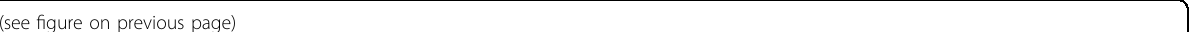
Fig. 3 PARKIN knockout increases extended-access methamphetamine self-administration (EA METH SA) and METH reward. A Timeline of EA METH SA experiment. B , C Escalation of METH taking in Parkin gene knockout (PKO) rats as compared to wild-type (WT) rats during an increasing ratio schedule of reinforcement: FR1, FR2, and FR5. The PKO rats pressed for METH at a signi fi cantly higher rate than the WT rats ( B ) with a consequent higher consumption of METH ( C ). There was no signi fi cant difference between PKO and WT rats in respect of the number of presses for saline ( B inset, n = 4/group). * p < 0.05, ** p < 0.01, *** p < 0.001, n = 11/group. D Total amount of METH consumed by PKO rats was signi fi cantly higher than that consumed by WT rats ( + 39% ** p < 0.001). E Timeline of conditioned place preference experiment. F The PKO rats displayed a signi fi cantly higher preference for METH (4 mg/kg) than the WT rats. *** p < 0.001 as compared to the respective saline (SAL) controls, # p < 0.05 WT vs. PKO, n = 6/ group. Data are expressed as mean ± SEM. Abbreviations: CPP conditioned place preference, FR fi xed